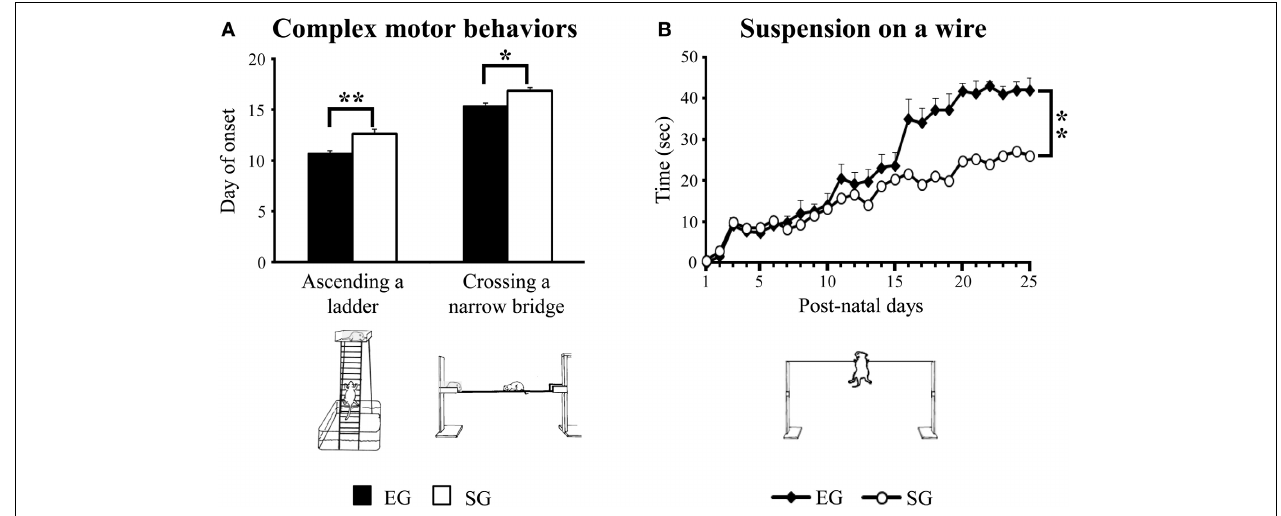
FIGURE 5 | Results of pre-reproductive maternal rearing condition on acquisition of complex motor abilities. Day of onset of ascending a ladder and crossing a narrow bridge (A) ; suspension time on a wire (B) ( ∗ p < 0 . 01; ∗∗ p < 0 . 001). Results are reported as mean ± s.e.m.